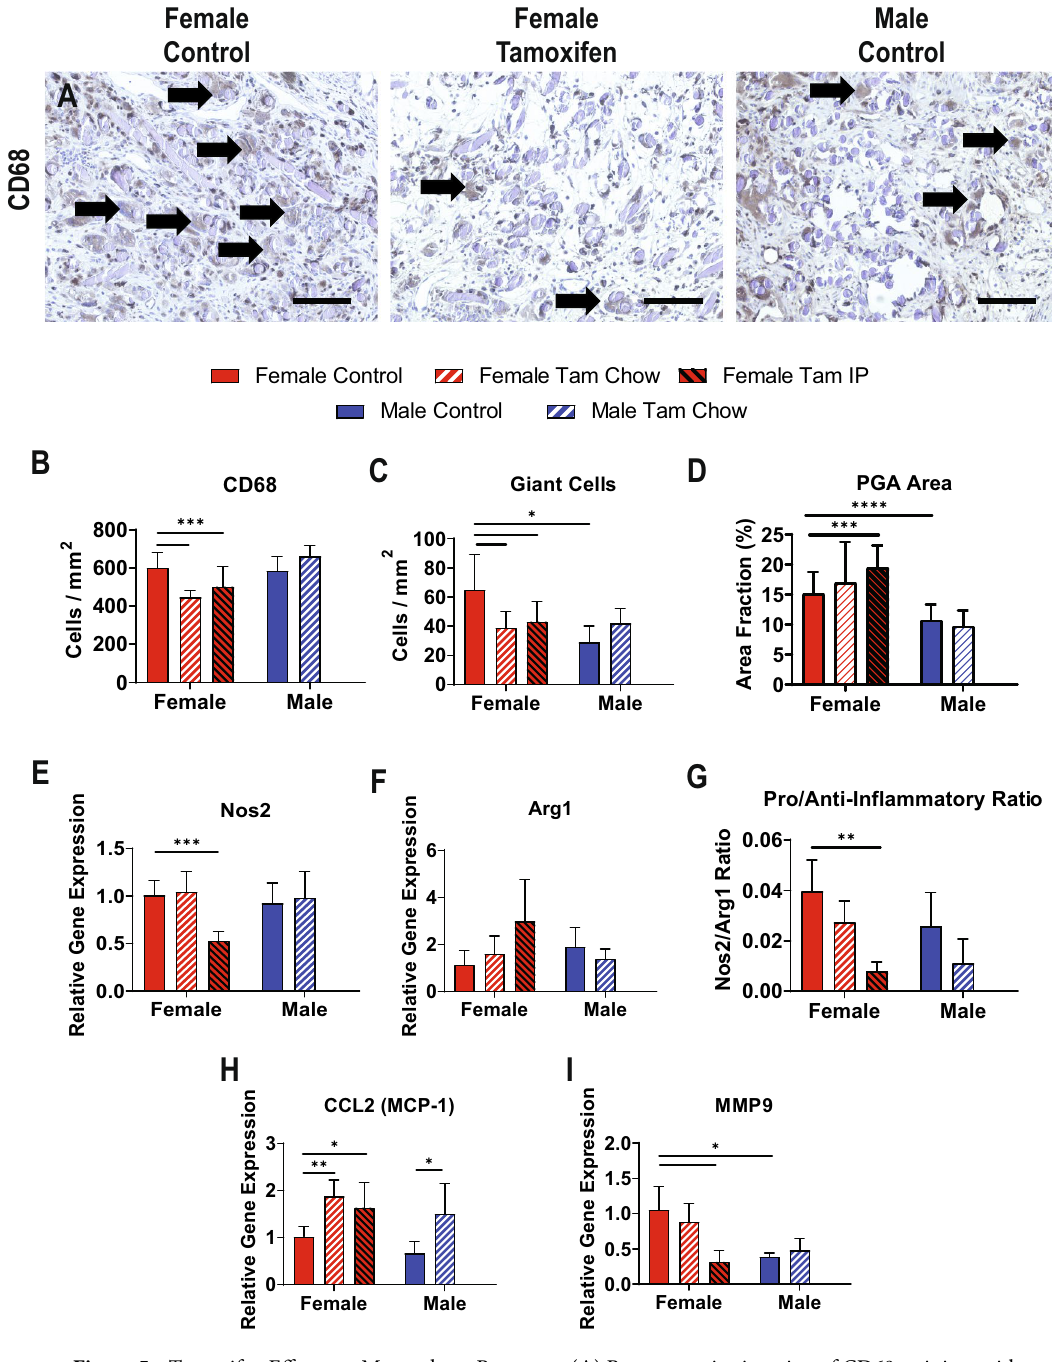
Figure 5. Tamoxifen Effects on Macrophage Response. ( A ) Representative imaging of CD68 staining, with giant cells labeled with black arrows. Total CD68 positive cells, including macrophages and giant cells quantified in ( B ) and giant cells alone quantified in ( C ). ( D ) Quantification of PGA polymer remaining in the wall of the TEVG 2 weeks after implantation. RT-qPCR quantification of pro-inflammatory NOS2 ( E ), anti-inflammatory Arg1 ( F ), and the ratio of the markers ( G ). RT-qPCR quantification of two markers of macrophage recruitment and function, CCL2 ( H ) and MMP9 ( I ). Scale bars = 200 µm. N = 15–20 for histology measures ( B – D ), and N = 6 for RT-qPCR measures ( E – I ), all compared using t-tests. * p < 0.05, ** p < 0.01, *** p <